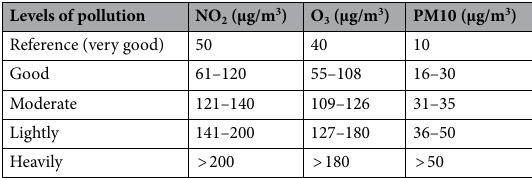
Table 3. Pollutant threshold ranges associated to selected levels for this study from the WHO guidelines.